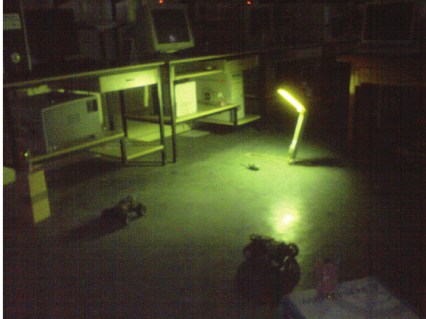
Figure 16: Experimental set up.